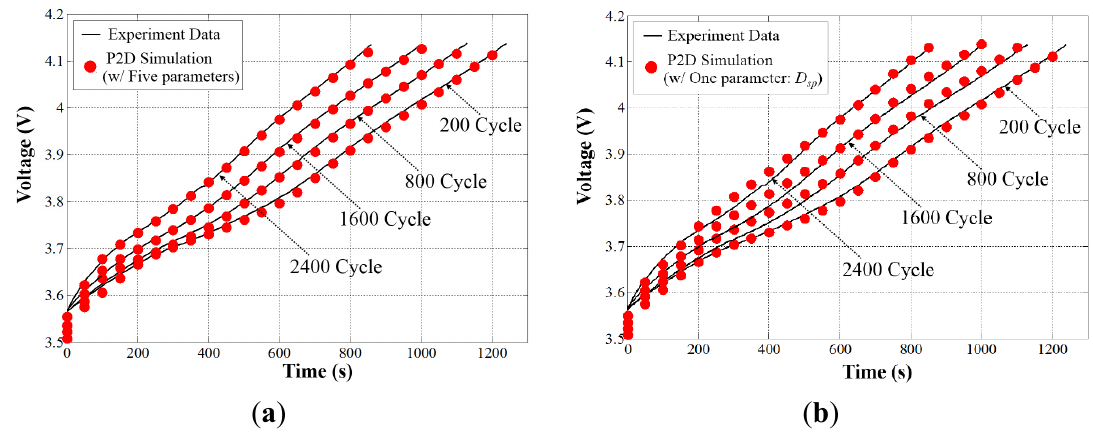
Figure 6. Comparision of the voltage obtained from the P2D model with experimental data. The dots represent the simulated result using the mean of estimated parameters: ( a ) all five model parameters estimated from experimental data; ( b ) only D sp estimated while other parameters are fixed at mean value of cycle